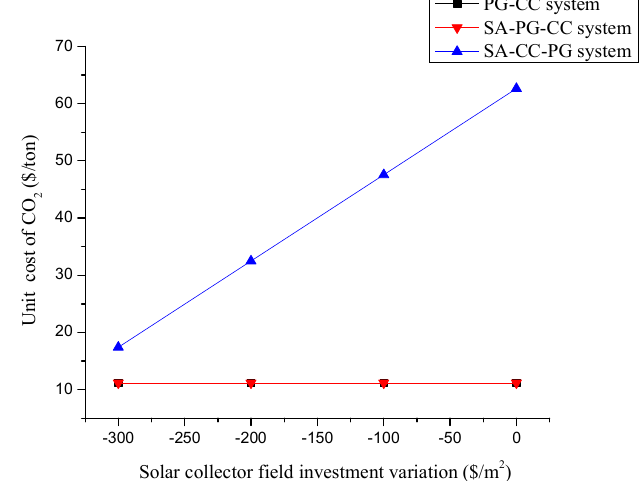
Figure 15. Variation in unit cost of CO 2 and solar-collector field investment for coal-fired power-generation system with MEA-based CO 2 capture (PG-CC), solar-aided coal-fired power generation with CO 2 capture (SA-PG-CC) and solar-aided CO 2 capture coal-fired power generation (SA-CC-PG).